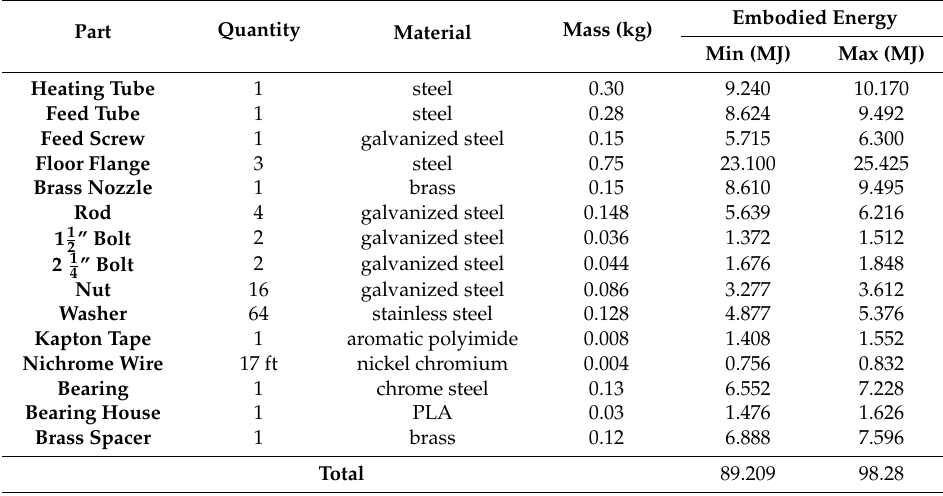
Table 1. Embodied energy for the barrel assembly of the recyclebot.